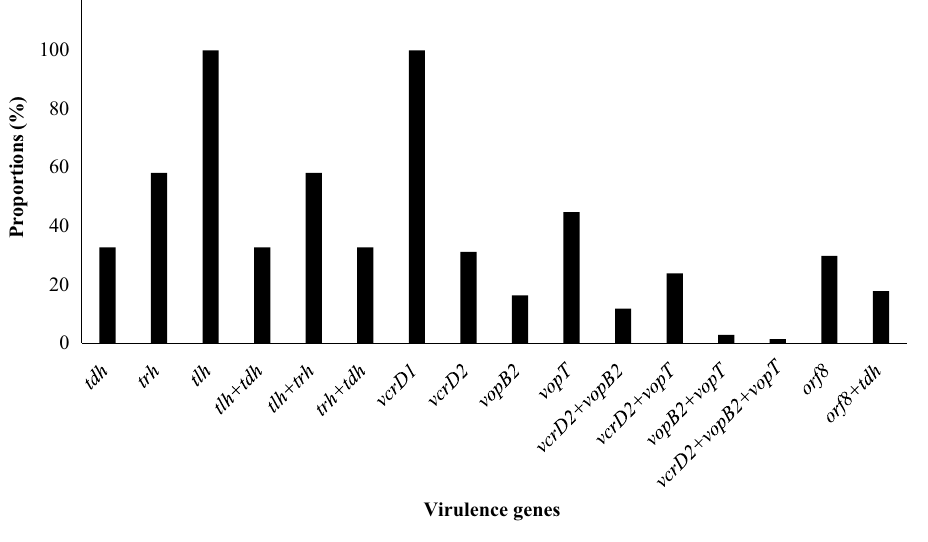
Figure 3. Virulence genes detected in V. parahaemolyticus